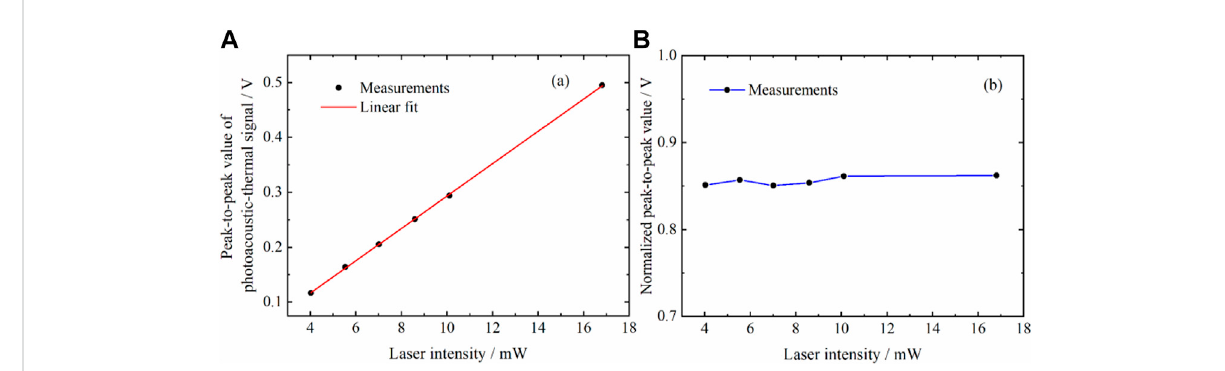
FIGURE 6 (A) Peak-to-peak values of photoacoustic-thermal signals under different light intensities; (B) Normalized peak-to-peak values of photoacoustic-thermal signals under different light